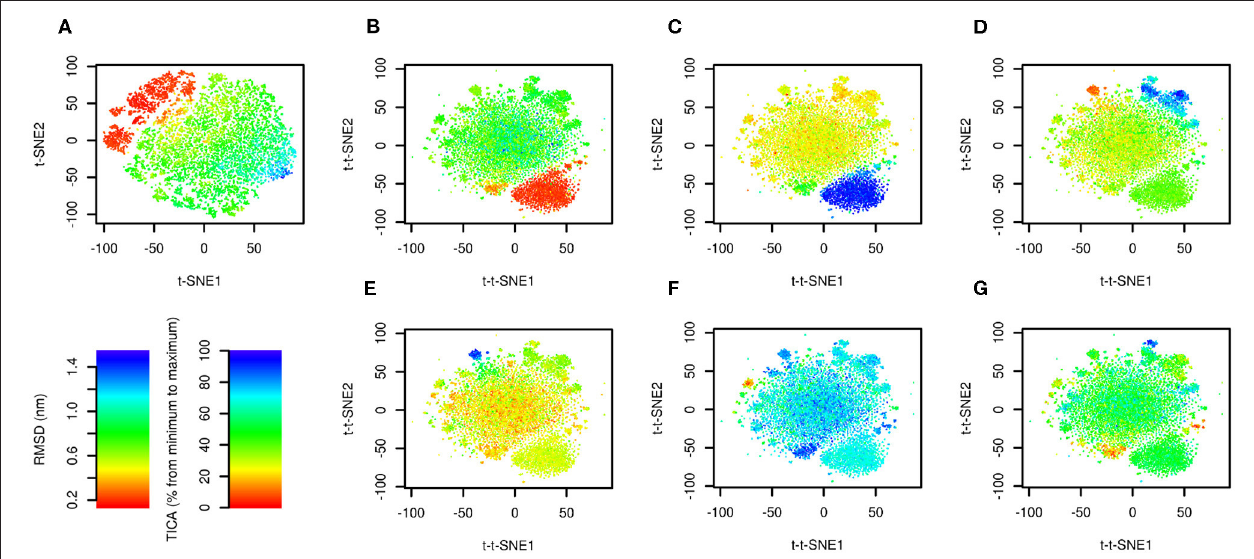
FIGURE 2 | Time-lagged t-SNE (t-t-SNE) applied on 208.8 µ s of Trp-cage folding and unfolding. The trajectory was analyzed by t-SNE (A) and time-lagged t-SNE (B–G) . Points are colored by RMSD from the native structure (A,B) and by the first (C) , second (D) , third (E) , fourth (F) , and fifth (G) TICA coordinate.